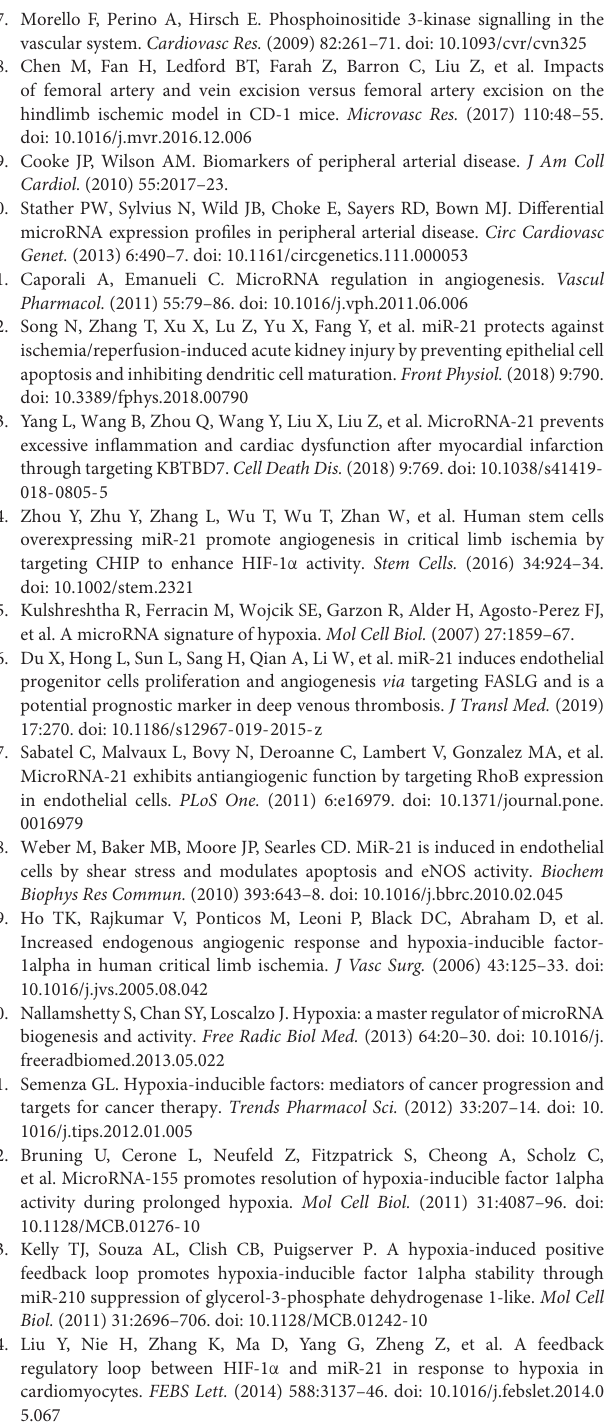
Supplementary Figure 1 | The expression of miR-21 in calf tissue in wild-type and mir-21-/- mice after limb ischemic surgery. Supplementary Figure 2 | (A) The study design of in vitro hypoxia in HUVECs mimicking limb ischemia. (B) The expression of miR-21 in HUVCs treated with miR-21 mimic or inhibitor at the indicated